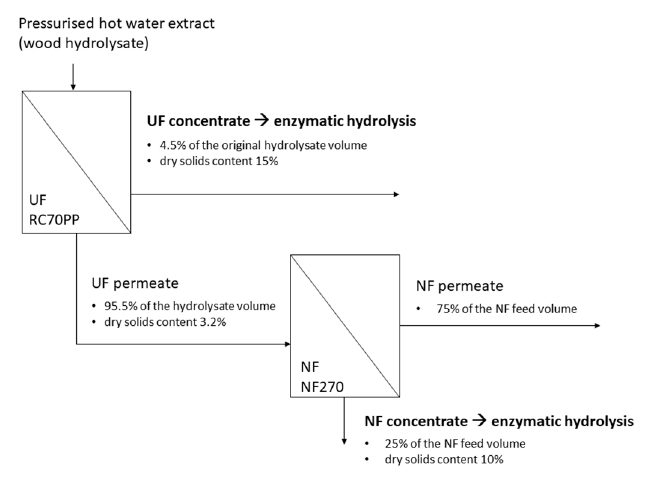
Figure 1. The membrane filtration process used to produce the carbohydrate fractions to enzymatic